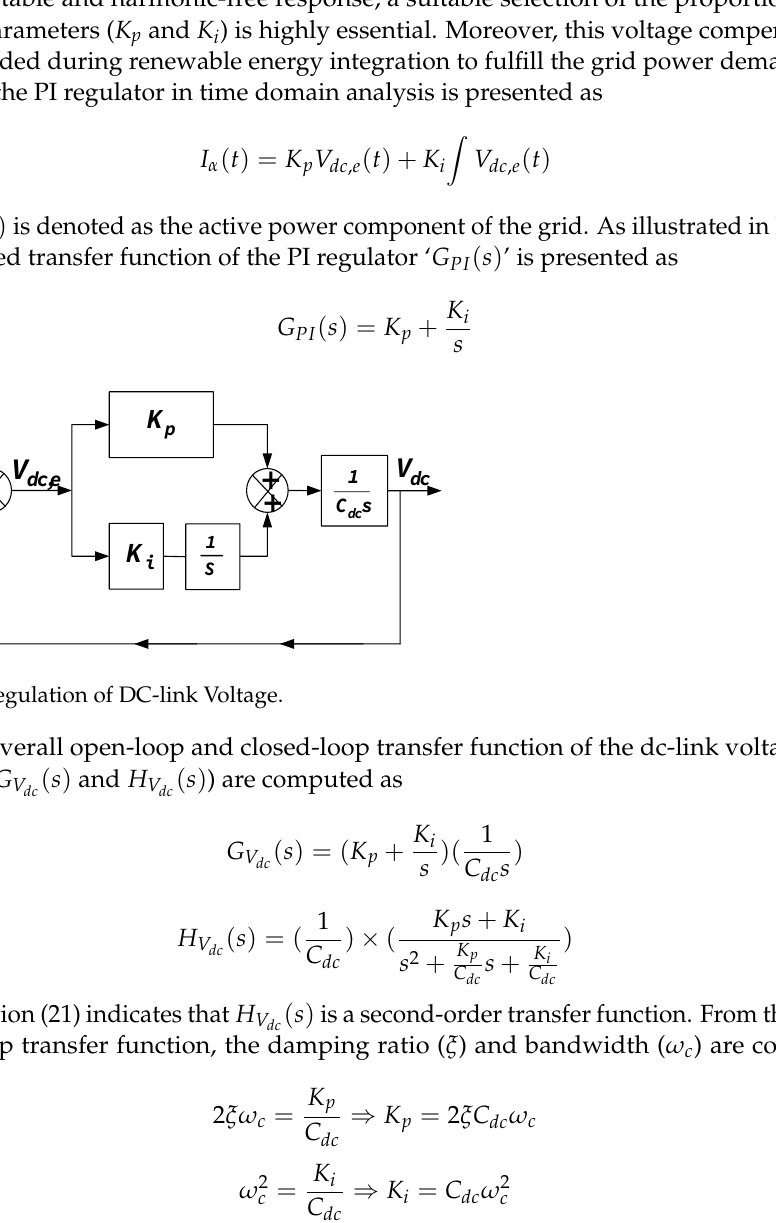
( s ) at different ω c is shown dc (𝑠) at different 𝜔 𝑐 is 𝑑𝑐